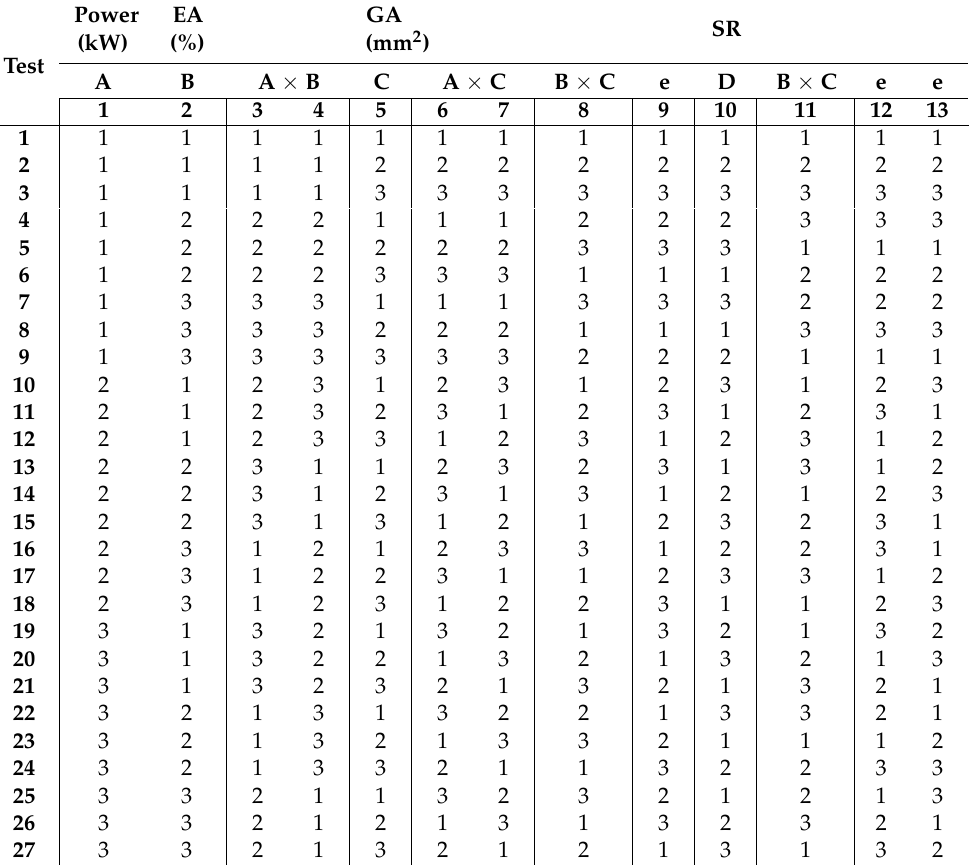
Table 3. Matrix L 27 , with indication parameter (1, 2, 5, 10), interaction (3, 4, 6, 7, 8, 11), and independent (9, 12, 13)